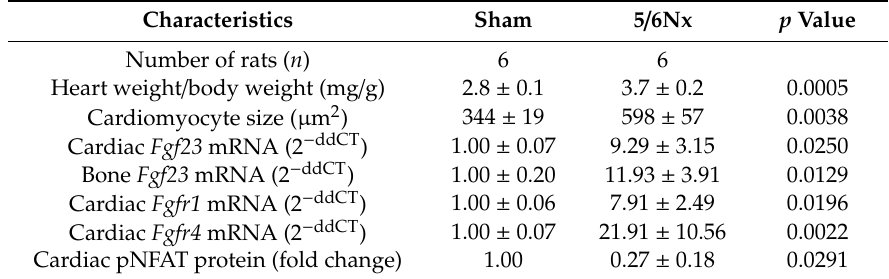
Table 1. Characteristics of sham and 5 / 6 nephrectomized (5 / 6Nx) rats.